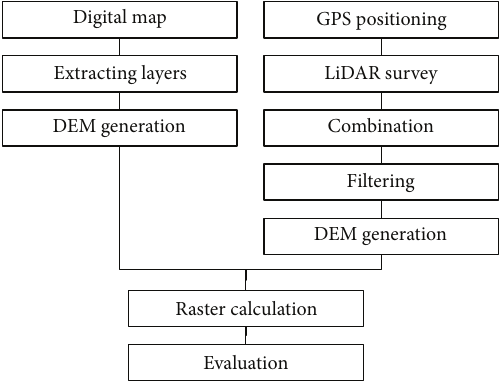
Figure 5: Main LiDAR processing steps in this study.